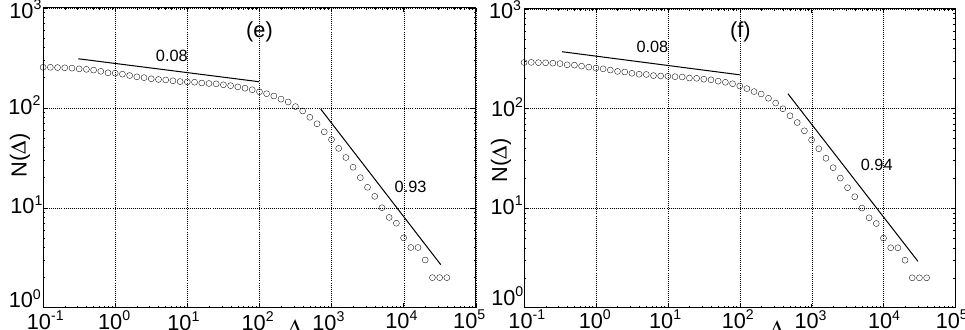
Figure 7. Number of N ( ∆ ) intervals of ∆ length, which contain at least one reversal. The α -quenching by energy ( γ = 1). ( a ) ν = 2.0; ( b ) ν = 2.2; ( c ) ν = 2.3; ( d ) ν = 2.6; ( e ) ν = 2.8; ( f ) ν = 3.3.